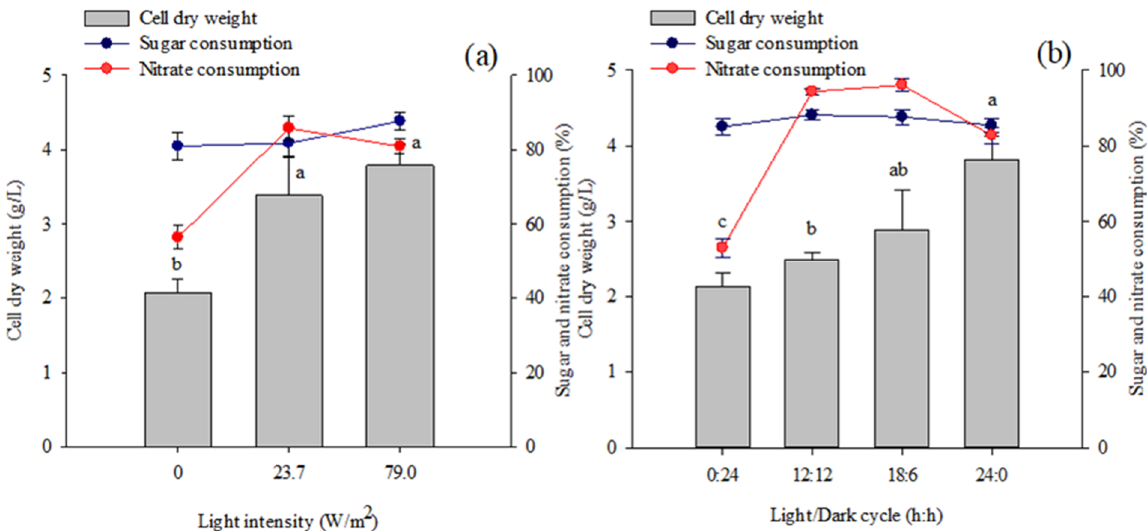
Figure 5. Effect of ( a ) light intensity and ( b ) light/dark cycle length on biomass production and percentage of sugar and nitrate consumption of Coelastrella sp. KKU - P1 cultivated in molasses-based medium. Different lowercase letters on the top of the bars indicate significant effects of light intensity or length of light/dark cycles on biomass production ( p ≤ 0.05, ANOVA with Duncan’s multiple range test).